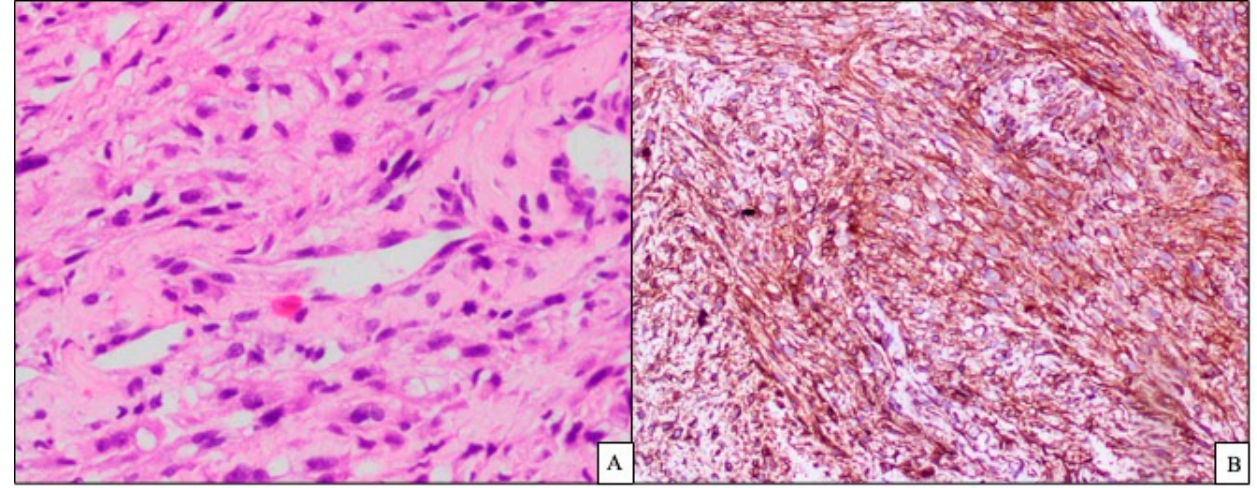
Figure 4. Histopathology showing spindle cells arranged in fascicles with ( A ) nuclear atypia 20× and ( B ) immunohistochemistry CD 99-positive.